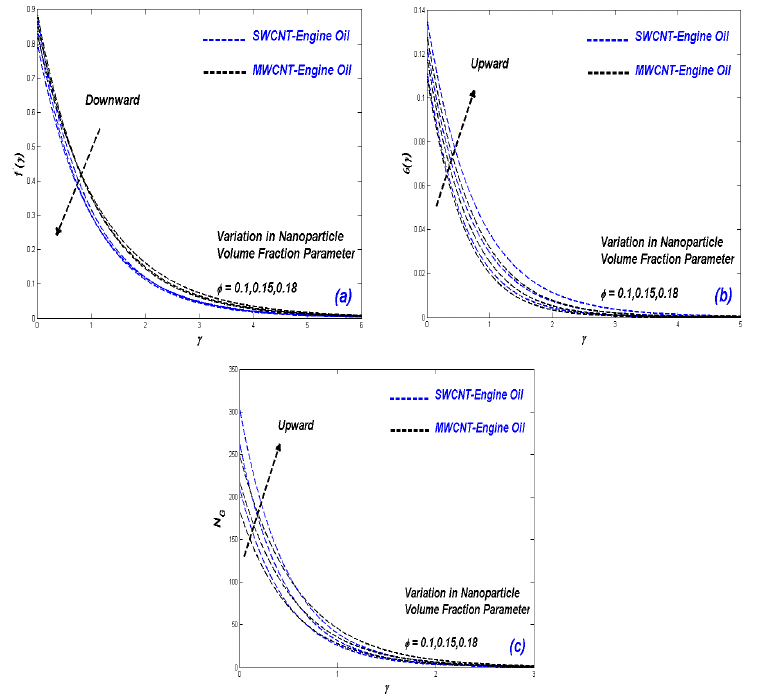
Figure 8. ( a ) Velocity change with 𝜙 ; ( b ) Temperature change with 𝜙 ; ( c ) Entropy change with 𝜙 .